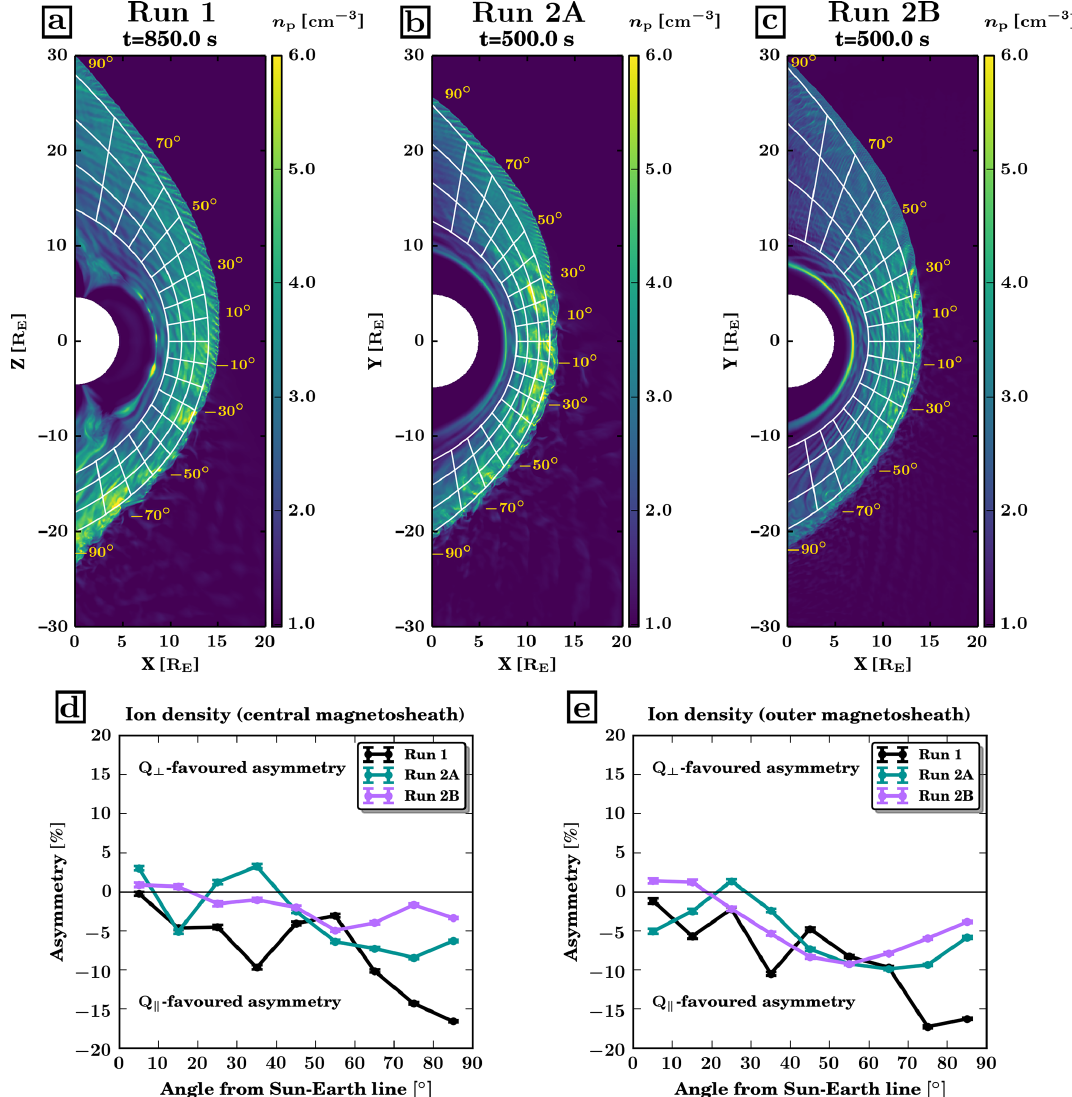
Figure 6. Same format as in Fig. 3 but for the ion